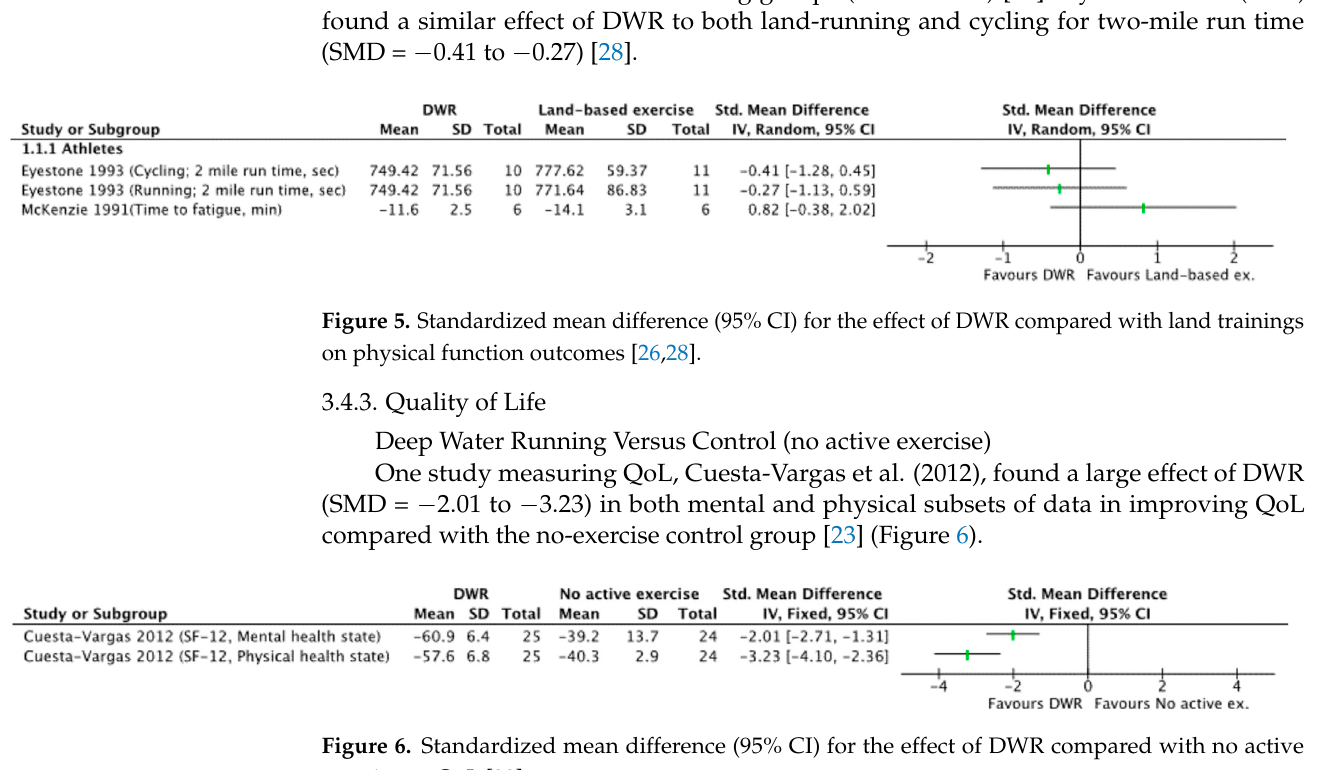
Figure 4. Standardized mean difference (95% CI) for the effect of DWR compared with no active exercise on physical function outcomes [24].